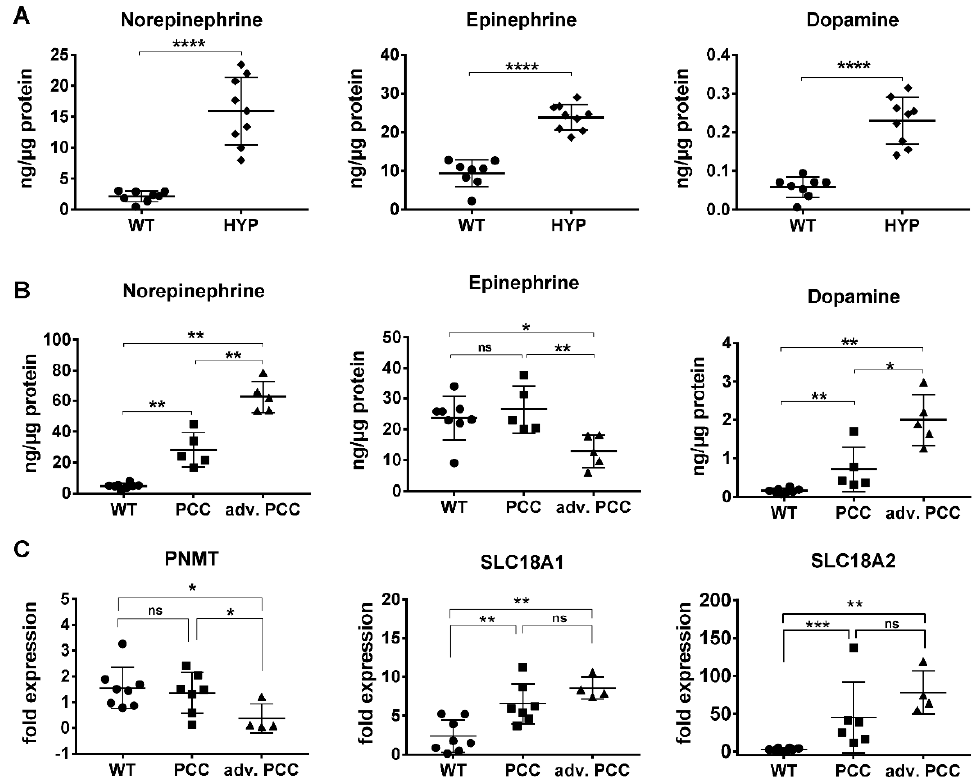
Figure 1. Targeted metabolomics and gene expression in rat adrenals. ( A ) Catecholamine measurements in adrenal medulla of 4–5 month-old wildtype (WT) and MENX rats with hyperplasia (HYP). Metabolites were normalized to the protein content of the gland. ( B ) Catecholamine measurements of >7-month-old WT rats, or rats with pheochromocytoma (PCC) or advanced (adv.) PCC. Metabolites were normalized as in A. ( C ) qRT-PCR-analysis of genes involved in catecholamine synthesis and transport. Depicted is the fold expression normalized against four house-keeping genes. All animals were 7–9 months old. ( A – C ) values + SD, p -values were calculated by Mann–Whitney test. (**** < 0.0001, *** < 0.001, ** < 0.01, * <0.05, ns ≥ 0.05).